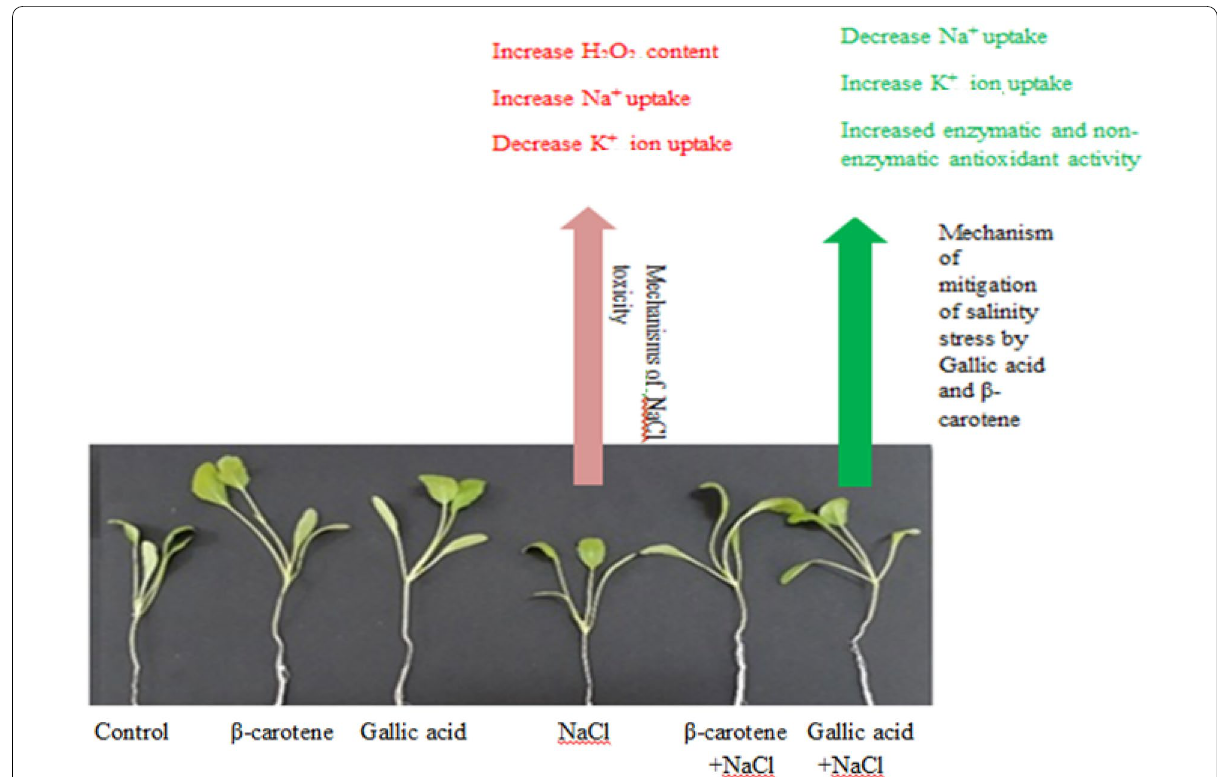
Fig. 8 The NaCl detrimental impact and mitigation mechanisms of β‑carotene and gallic acid in Lepidium